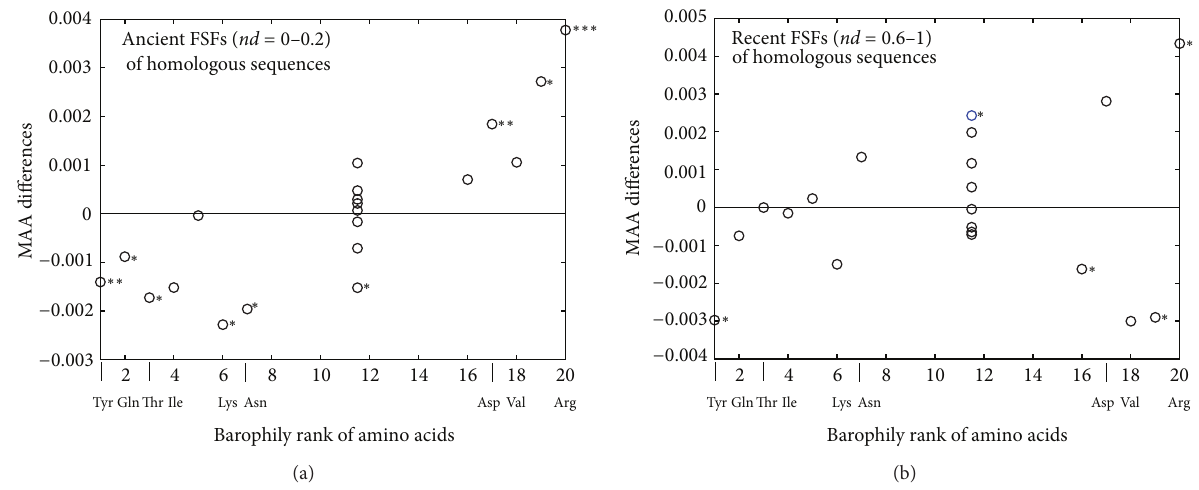
Figure 7: MAA analysis of matching FSFs of different evolutionary age. (a) Organisms display the same preferences for amino acids within ancient FSFs ( 𝑛𝑑 = 0–0.2) of homologous sequences as they do in entire sequences. However, here Ser is also preferred more by the barophile. (b) Many amino acid preferences are erased in evolutionarily recent FSFs ( 𝑛𝑑 = 0.6–1.0) of homologous sequences. Some preferences were even reversed; the normally barophilic Gly and Ser are now used significantly more by the nonbarophilic organism. Statistical significance is marked with stars as described in Figure 2. A total of 55 recent and ancient FSFs were analyzed. an ancestral composition that is refractory to change (e.g., Thr and